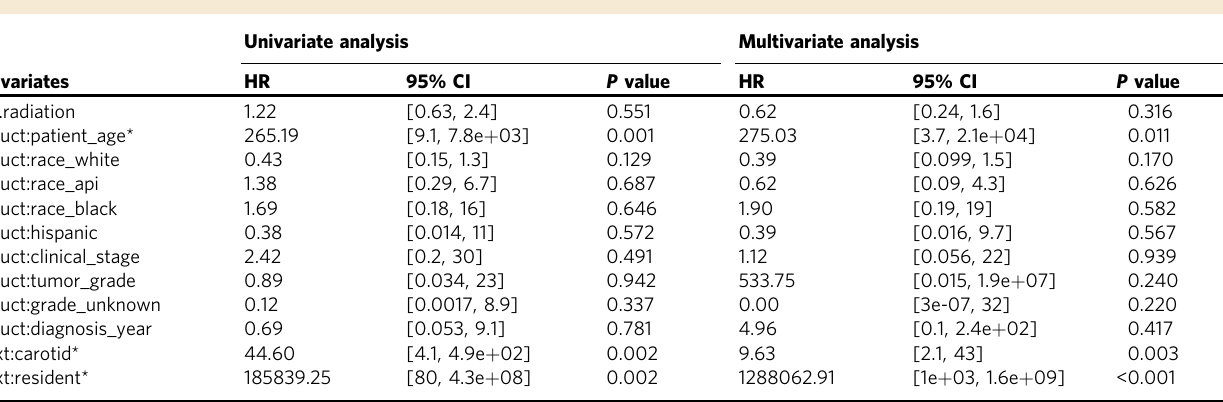
Table 5 Univariate and multivariate covariate-speci fi c HR for radiation vs. active monitoring for prostate cancer. Univariate analysis Multivariate analysis Covariates